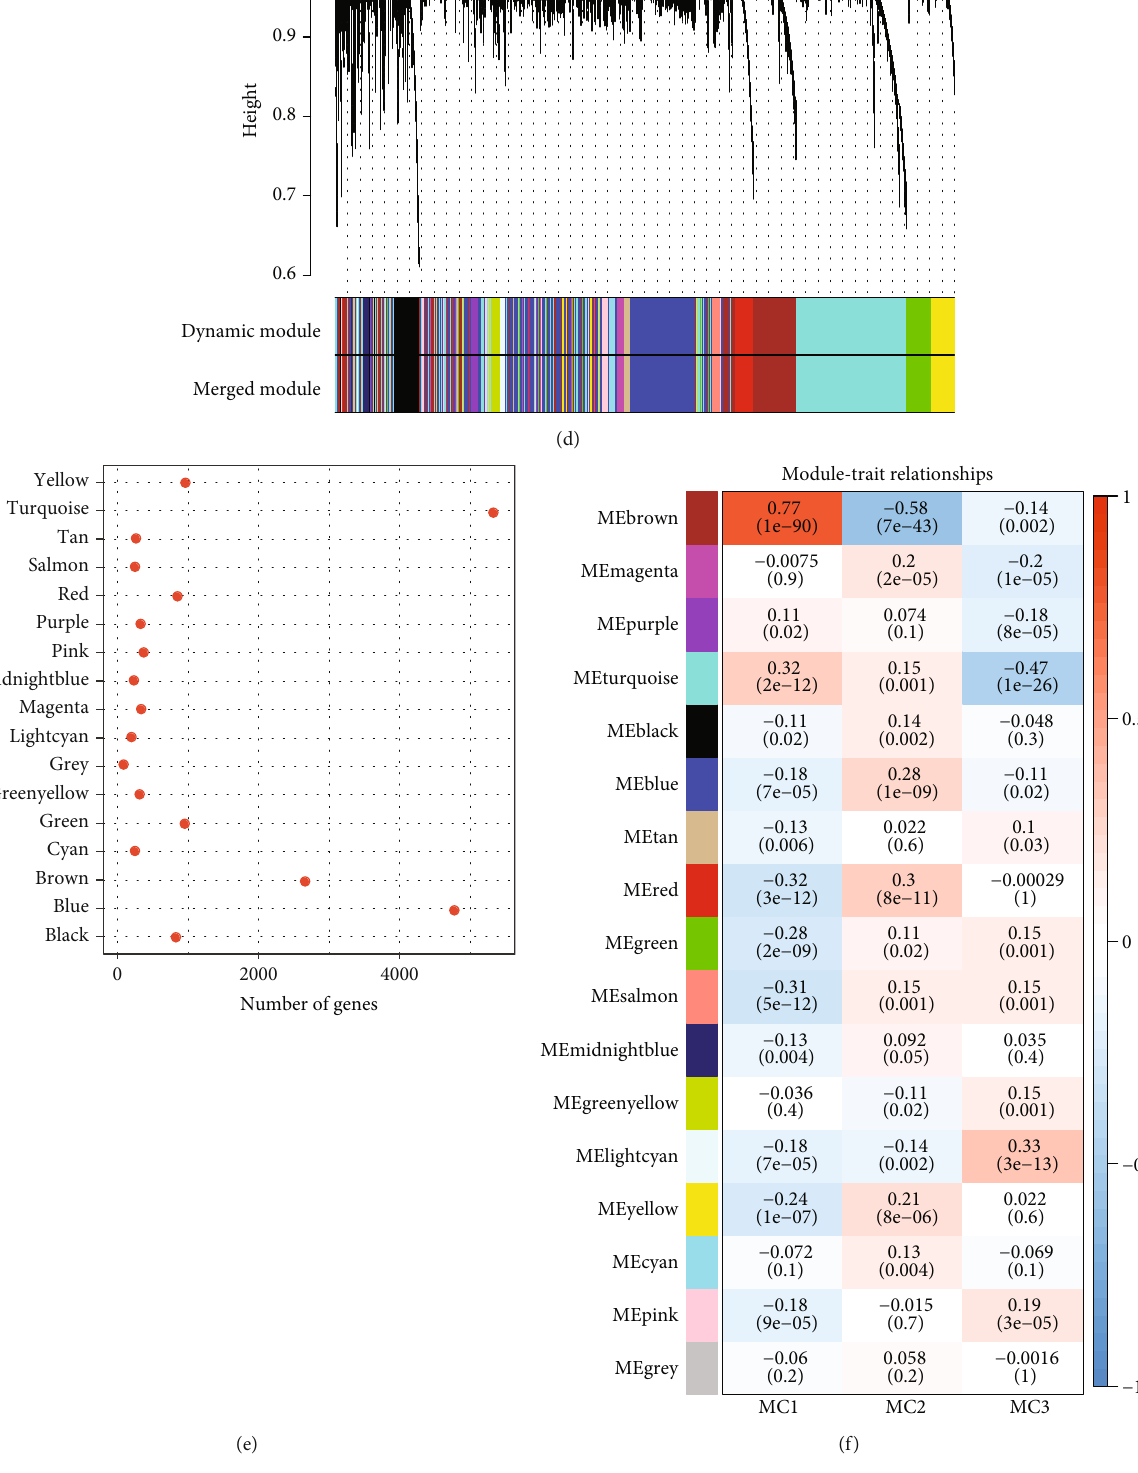
Figure 9: (a) Clustering tree of each sample. (b) Analysis of the scale-free fi t index for various soft-thresholding powers ( β ). (c) Analysis of the mean connectivity for various soft-thresholding powers. (d) Dendrogram of all di ff erentially expressed genes/lncRNAs clustered based on a dissimilarity measure (1-TOM). (e) Statistical analysis of the number of genes in each module. (f) Correlation between each module and